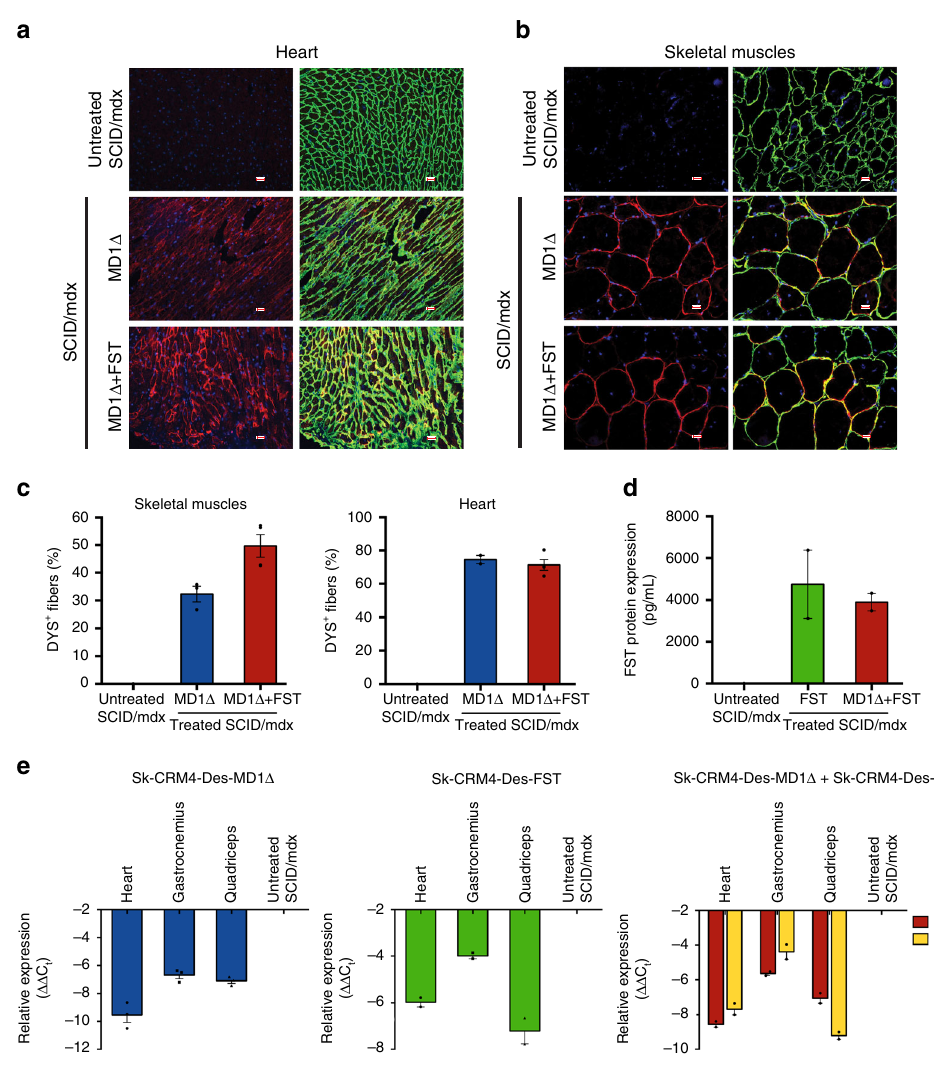
Fig. 5 Human MD1 and human FST expression analysis in immunode fi cient dystrophic SCID/mdx mice. The ssAAV9-Sk-CRM4-Des-MD1 Δ and ssAAV9- Sk-CRM4-Des-FST vectors were injected either alone (indicated as MD1 Δ , FST) or in combination (indicated as MD1 Δ + FST) in SCID/mdx mice at a dose of 2 × 10 10 vg/mouse. a , b Immuno fl uorescence staining for laminin (LAM, in green), human dystrophin (DYS, in red) and DAPI nuclear staining (in blue) was performed on sections from heart ( a ) and skeletal muscles ( b ) of treated and untreated control SCID/mdx mice. The scale bars indicate 100 μ m. c Quanti fi cation of the DYS + fi bers detected out of the total number of LAM + fi bers in the heart and skeletal muscle tissue sections from treated and untreated control SCID/mdx mice. d Quanti fi cation of human FST protein (in pg/50 mg of skeletal muscle tissue) as determined by ELISA. e Human MD1 Δ and FST mRNA quanti fi cation in the heart and the skeletal muscles (i.e., gastrocnemius, quadriceps) of treated and untreated control SCID/mdx mice, expressed relative to the murine housekeeping gene Gapdh by qRT-PCR. Mice were injected at 4 weeks and euthanized 22 weeks later. The data were represented as mean + s.e.m. ( n = 2 –